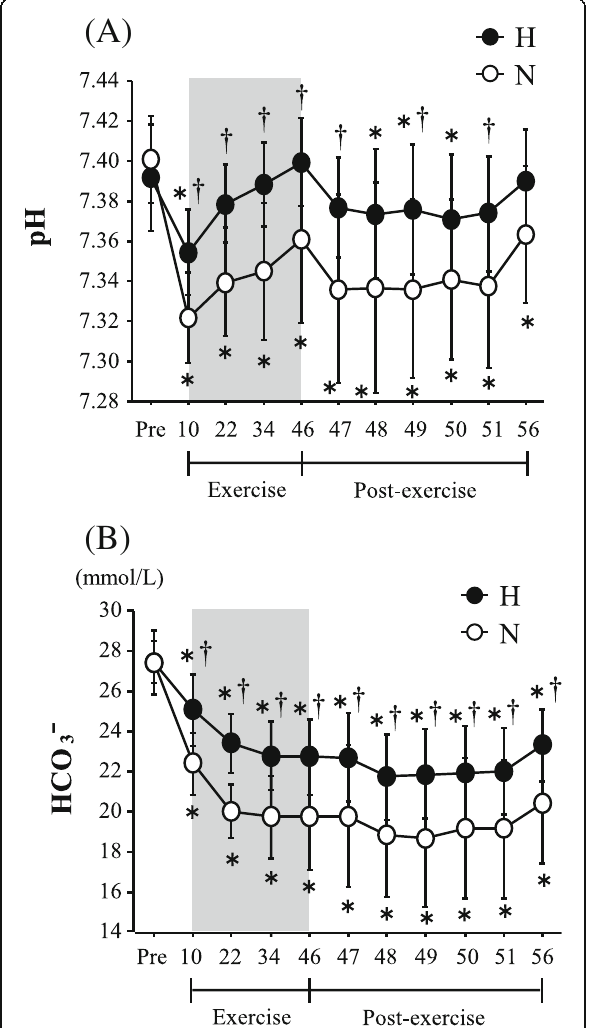
Fig. 3 Changes in blood pH level ( a ) and HCO 3 − concentration ( b ). Values are means± SE. The shaded box indicates the duration of exercise. *Significant difference compared with Pre. † Significant difference between the N and H